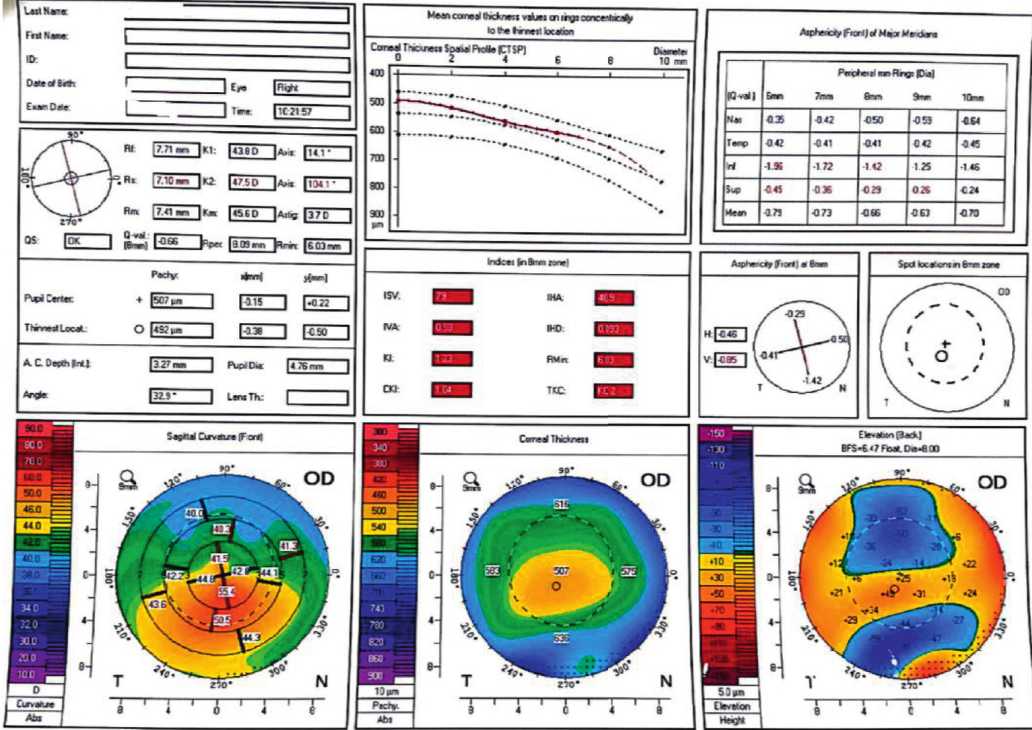
Figure 3: Pentacam of the right eye of a patient in group 3